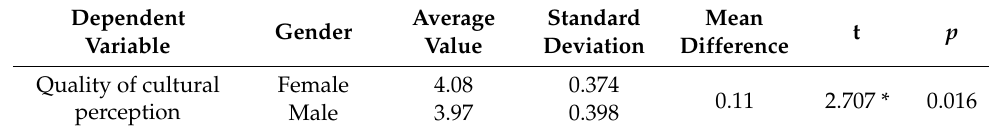
Table 3. Independent sample t -test for the effect of gender on perceived quality of culture (N = 417). Average Dependent Gender Variable Quality of cultural